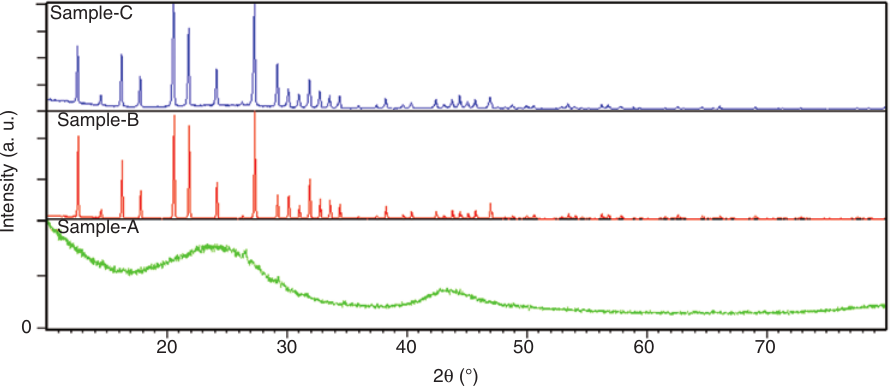
Figure 5: XRD pattern of pure carbon (A), pure potash alum (B), and maximum conducting composite (C).